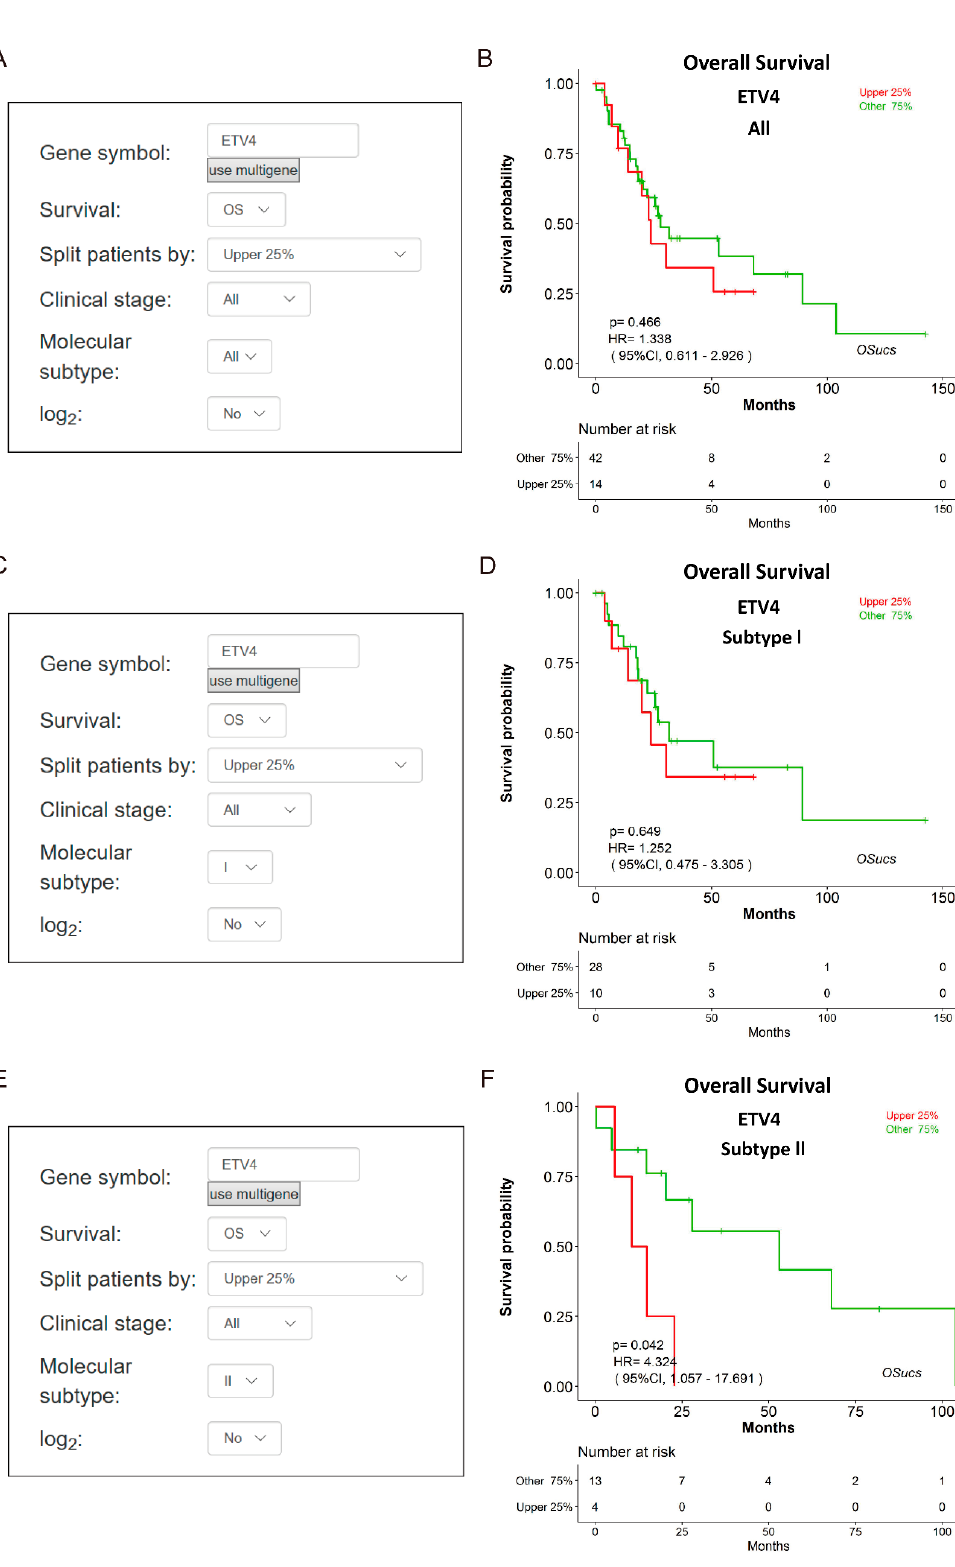
Figure 4. Evaluation of the prognostic value of ETV4 (ETS variant transcription factor 4) gene in OSucs. ( a , c , e ) Screenshots of molecular subtype selection in OSucs main interface. ( b , d , f ) Kaplan-Meier plots for ETV4 (OS) in All, Subtype I and Subtype II UCS, respectively.